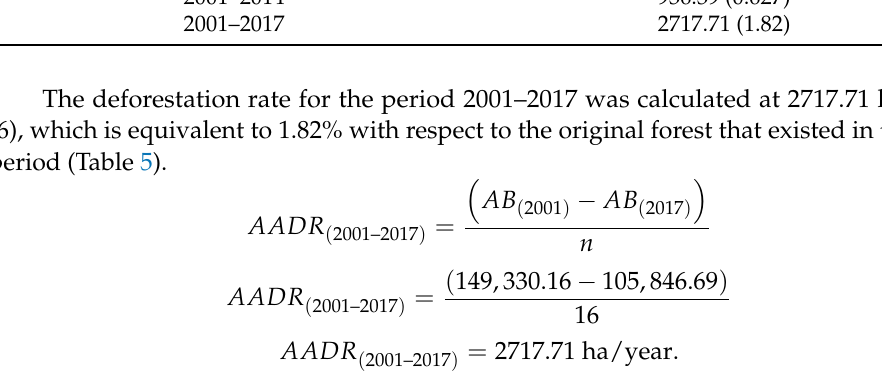
Table 5. Deforestation rate in the ITT Oil Block of the Ecuadorian Amazon region. Period Annual Deforestation Rate